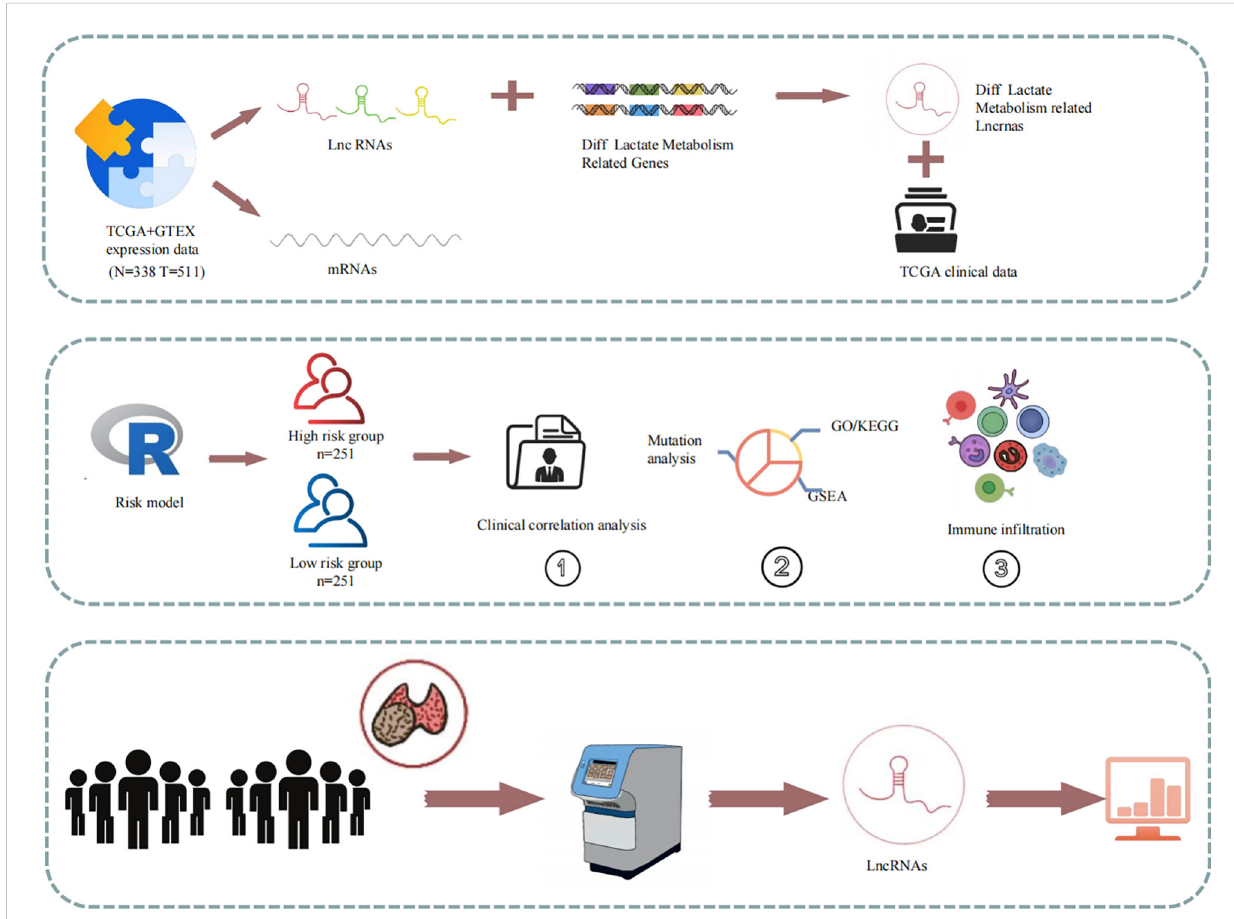
FIGURE 1 Schematic of the study design. Expression and clinical data from the TCGA database were combined to create a risk model for prognostic, enrichment, mutation, and immune correlation analyses. The expression of the six LRLs was veri fi ed through in vitro